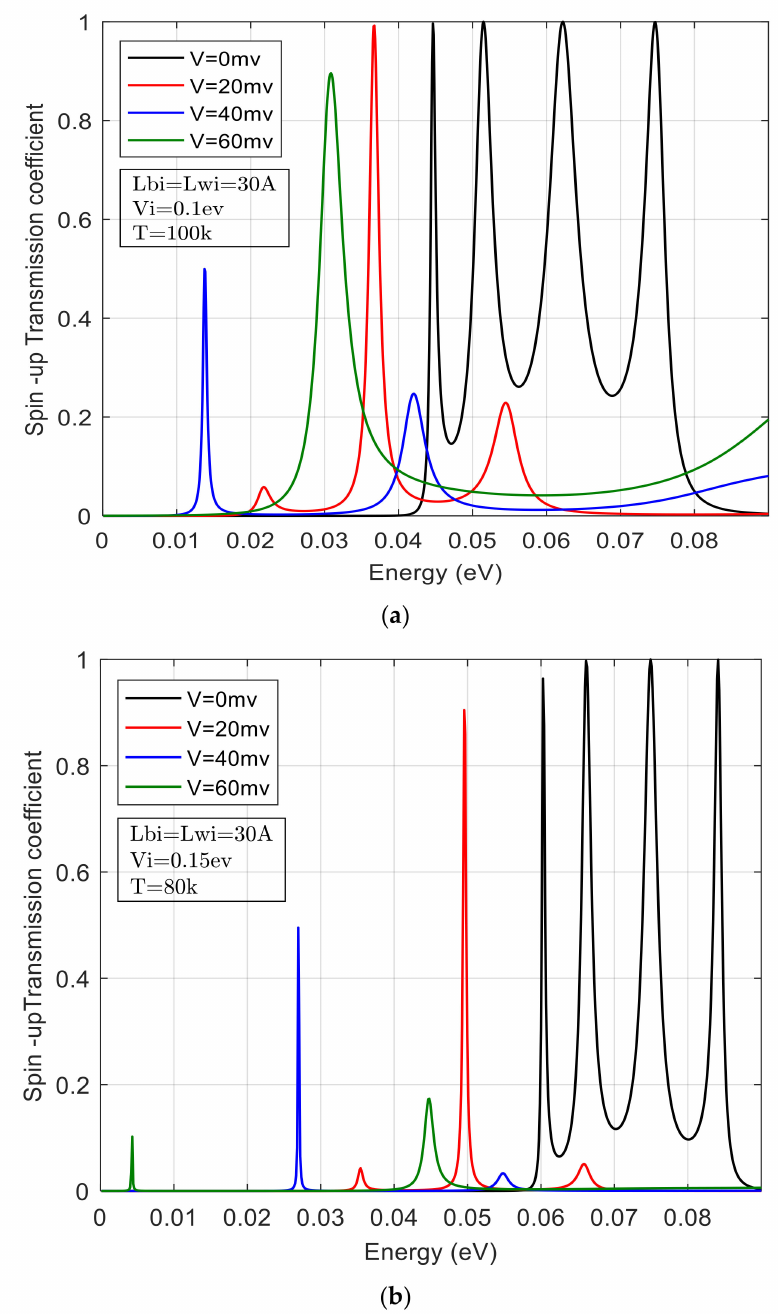
Figure 9. ( a ): Transmission coefficient of spin-up holes as a function of incident energy for different applied bias voltages (N = 5 and T = 100 K). ( b ): The Transmission coefficient of spin-up holes as a function of incident energy for different applied bias voltages (N = 5 and T = 80